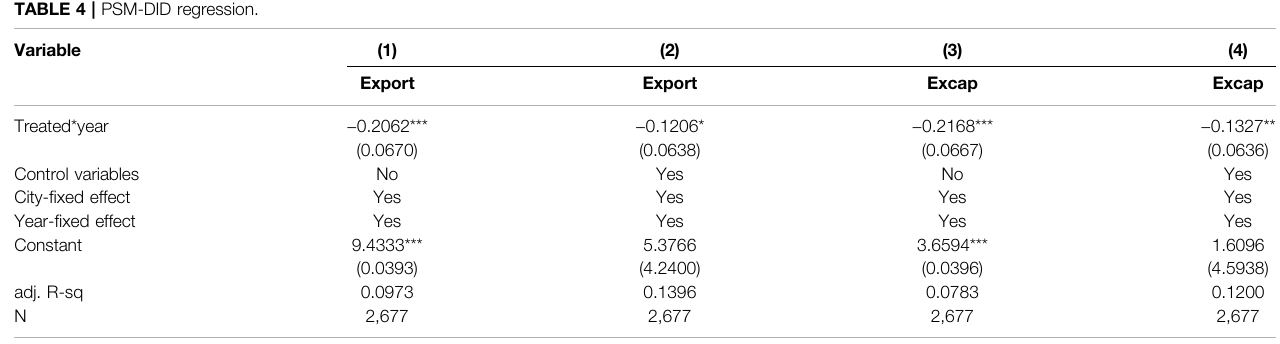
TABLE 4 | PSM-DID